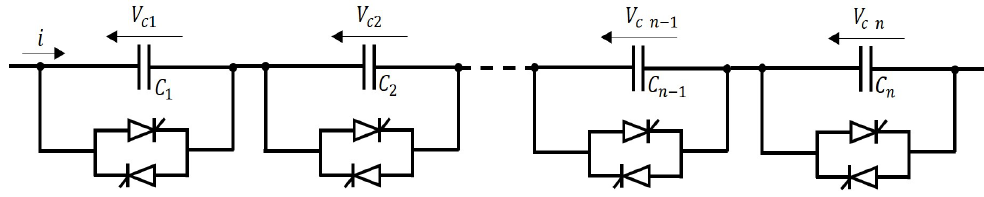
Figure 6. Thyristor-Switched Series Capacitor (TSSC) scheme